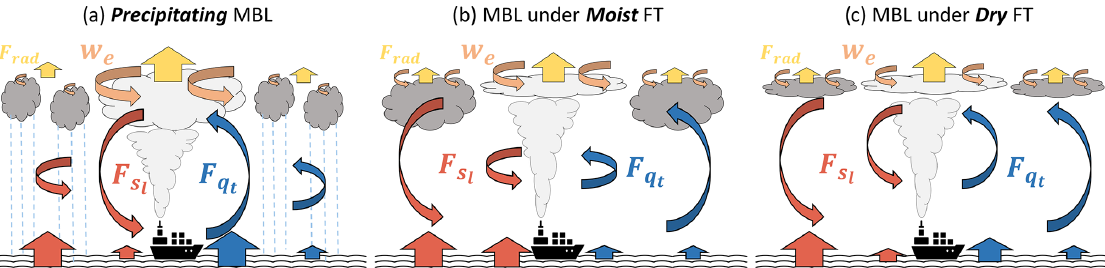
Figure 12. This schematic illustrates the responses of the entrainment rate (light red arrows), boundary-layer turbulence (curved arrows in the boundary layer), surface fluxes (arrows on the surface), and cloud radiative fluxes (yellow arrows on the top of clouds) to aerosol injections. Red arrows represent sensible heat flux, and blue arrows represent moisture flux. The size of the arrows represents the intensity. The center of the domain is the region perturbed by ship tracks; to the left and right of this are the unperturbed regions. Response tendencies are shown for three sets of MBL conditions: (a) precipitating boundary layer, (b) non-precipitating MBL under a moist FT, and (c) non-precipitating MBL under a dry